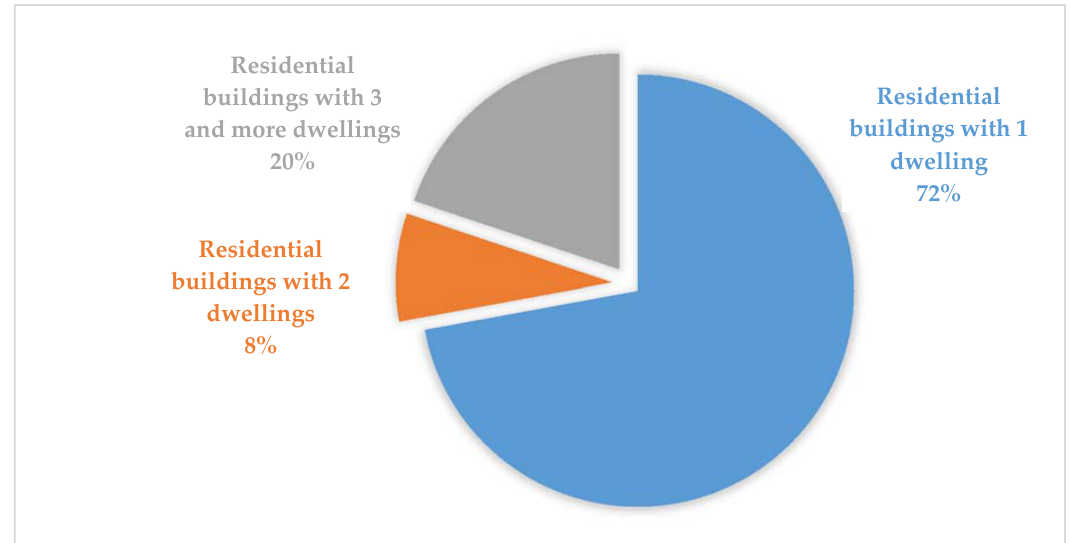
Figure 3. Dwellings by type of building in the urban settlement of Ub. The graph is altered by rounding up the values [88] (p. 234).The census data from 2011 show also sources of livelihood in Ub. Almost 40% of inhabitants of the urban settlement Ub are dependent persons, while around 35% of them have salary or other allowance based on work as primary source of livelihood, and around 18% has pension [89] (pp. 58–59). According to the date from the Statistical O ffi ce of the Republic of Serbia [90] average gross monthly salary in the Republic of Serbia in the December 2019 was 82,257 RSD (around 700 EUR), and in average 59,772 RSD net (around 508 EUR). Average monthly salaries in the municipality of Ub were on a lower level—74,182 RDS gross (around 631 EUR), and 53,687 RSD net (around 457 EUR). Appl. Sci. 2020 , 10 , x FOR PEER REVIEW